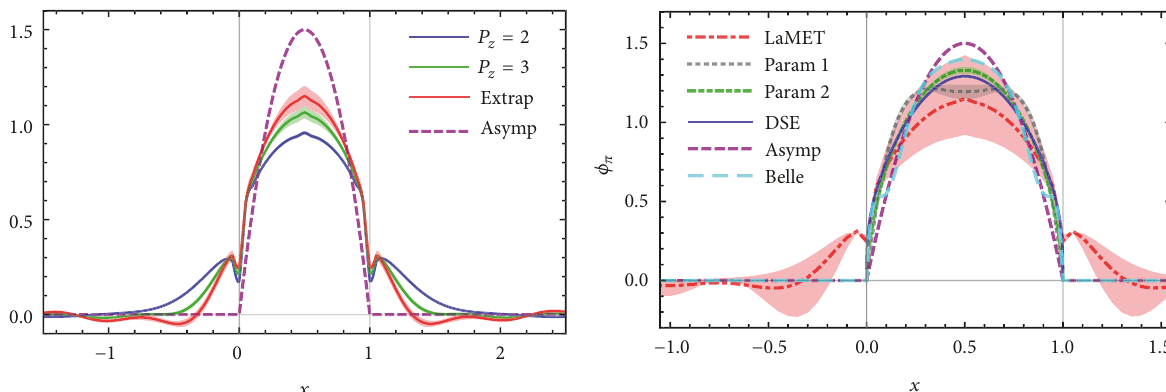
Figure 28: Improved pion DA obtained in the first lattice study [123] employing the quasidistribution approach. Left: 𝛿𝑚 = −260 MeV, momenta 0.86 GeV (blue), and 1.32 GeV (green), and extrapolated to 1/𝑃 2 3 = 0 (red), along with the asymptotic form 6𝑥(1 − 𝑥) (dashed line). Right: 𝛿𝑚 = −260 ± 200 MeV, extrapolated to 1/𝑃 2 3 = 0 (“LaMET,” red band), together with models and parametrizations: from Dyson-Schwinger equation (“DSE,” blue) [221], fit to Belle data (“Belle,” cyan) [222], parametrized fits to lattice moments (“Param 1,” gray and “Param 2,” green) [223] and the asymptotic form (“Asymp,” purple). Source: [123], reprinted with permission by the Authors and the American Physical